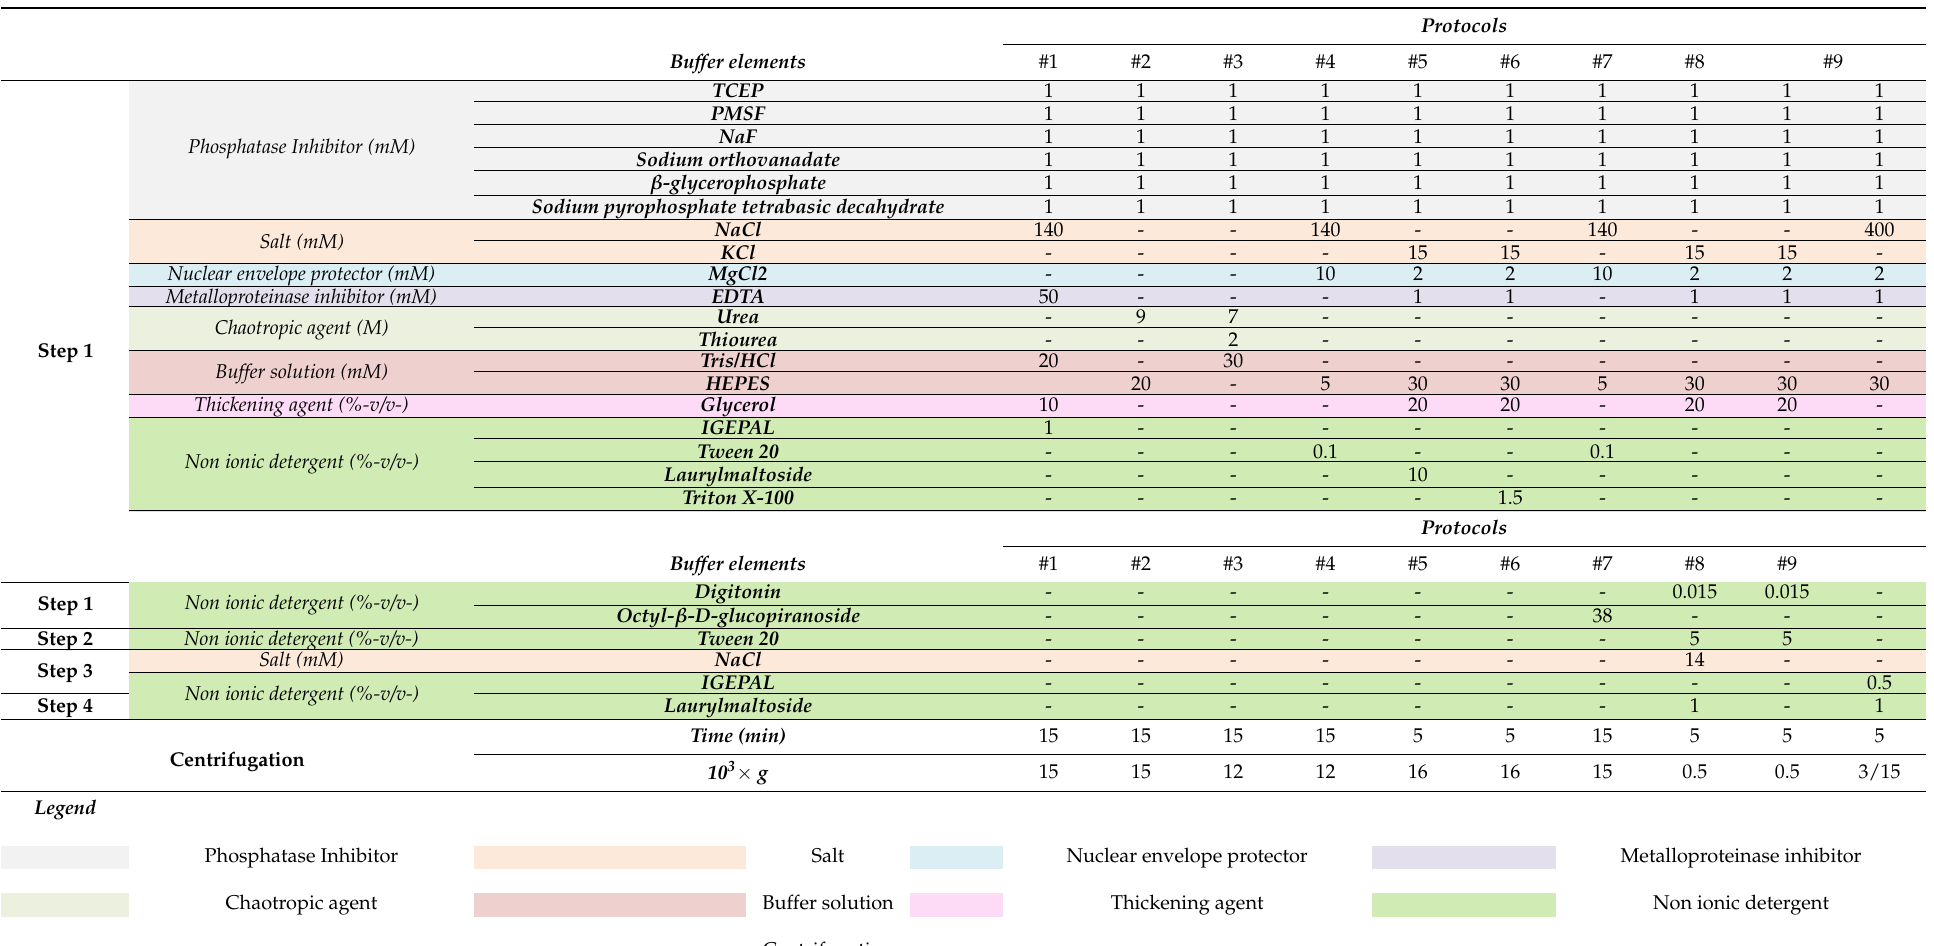
Table 1. Summary of protein extraction